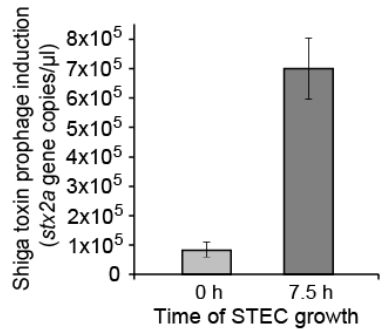
Figure 2. Quantification of prophage 933W induction in uninfected STEC cultures via quantitative PCR (qPCR). Primers are used against the stx2 subunit a gene at 0 and 7.5 h of STEC growth. The former represents a transfer of cells from an overnight growth into fresh media, and the latter represents when cell growth is stopped and the DNA harvesting procedure begins (see Methods). The average of three biological replicates and their error is plotted on the graph. The difference between the two time points is significantly different ( t -test, p < 0.05). Data from this experiment can be found in the Supplementary Materials (see Dataset). Table 1. Coverage of uninfected ATCC43895 (STEC)’s prophage and non-prophage regions . Represented is the raw coverage, the normalized coverage (to sequencing depth and region length), and the final transformed coverage (multiplied by 10 11 for better reading) of each of the 17 prophages and the non-prophage regions of STEC, in biological triplicates. Lysate Prophage or Not? Genomic Entity Raw Coverage Coverage Normalized Final Adjusted by Sequencing Depth Coverage and Entity Length (Raised to 10 11